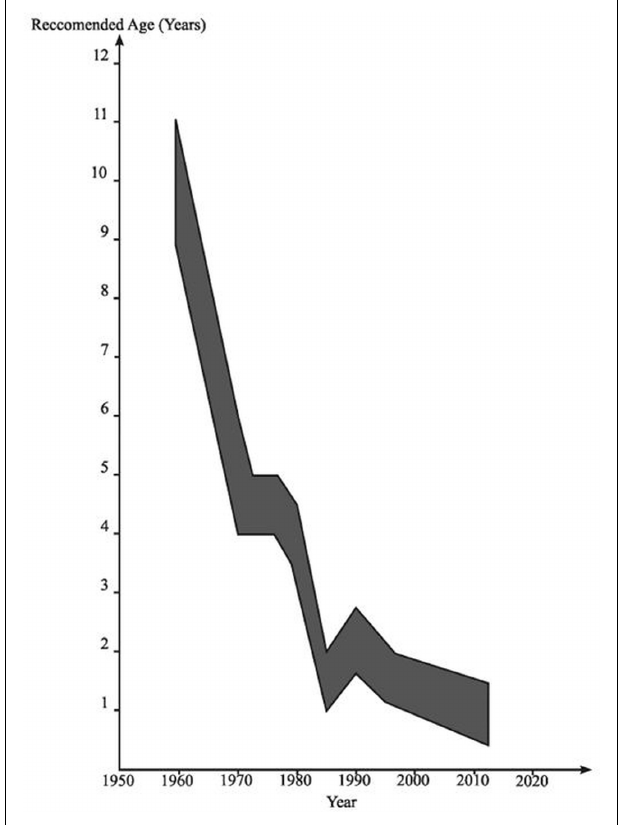
FIGURE 3 |The age at which orchidopexy has been advocated since the 1950s. Reproduced with modifications from Hutson and Beasley (1992).